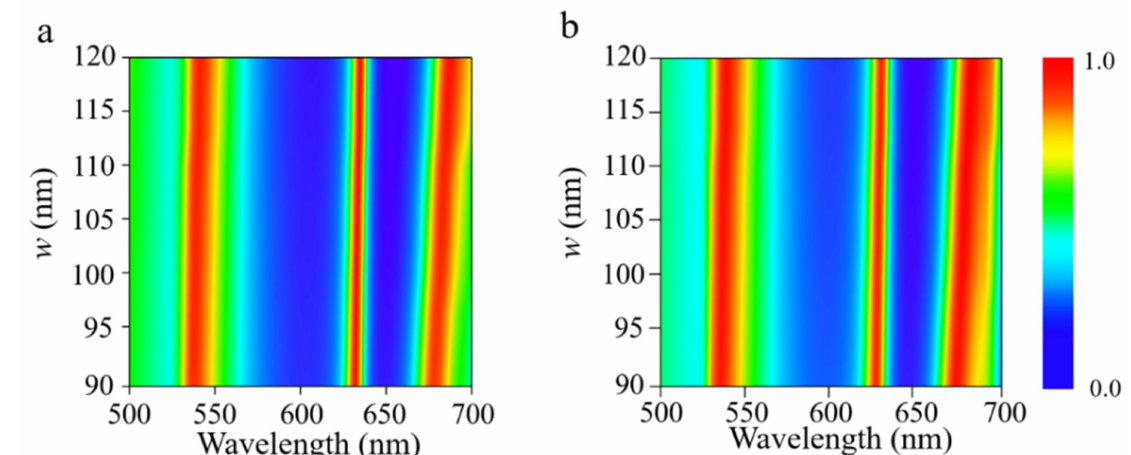
Figure 5. Absorption spectra of the proposed structure as a function of wavelength and the width w of α -MoO 3 nanoribbons with polarization along ( a ) [100] and ( b ) [001] crystalline directions of α -MoO 3 ; the width ratio constant is kept unchanged.